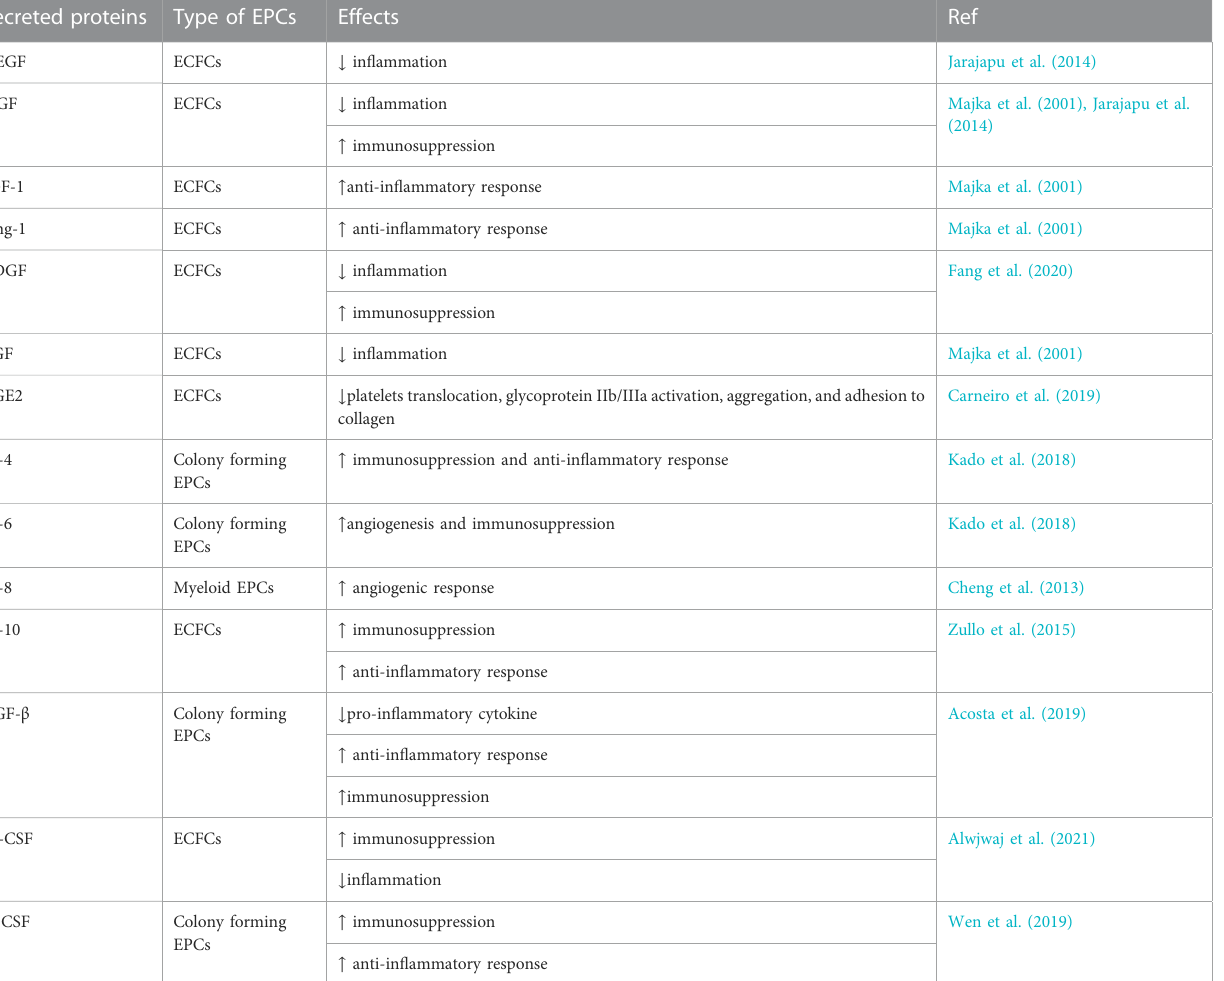
TABLE 2 Angiogenesis and anti-in fl ammatory proteins secreted by EPCs. Secreted